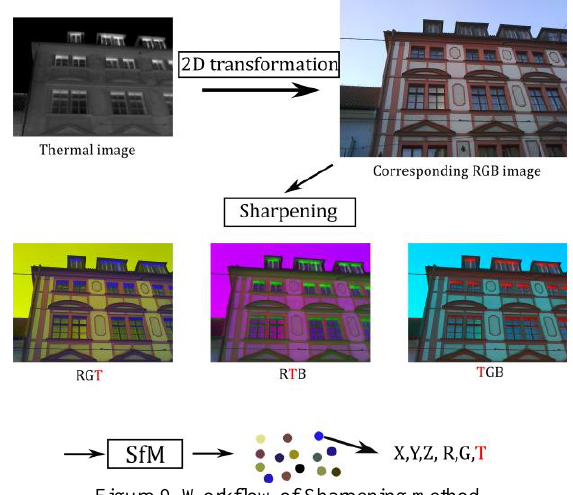
Figure 9. Workflow of Sharpening method.